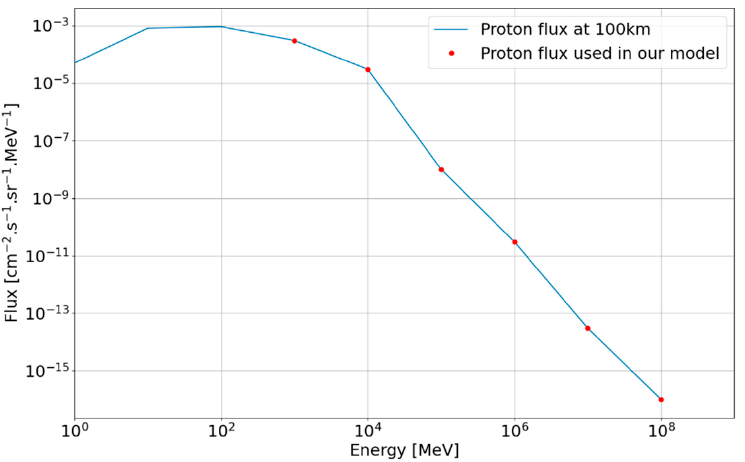
Figure 8. Discretization of the proton spectrum at 100 km of altitude based on the Swordy plot by William Hanlon [36] and the CRDB.